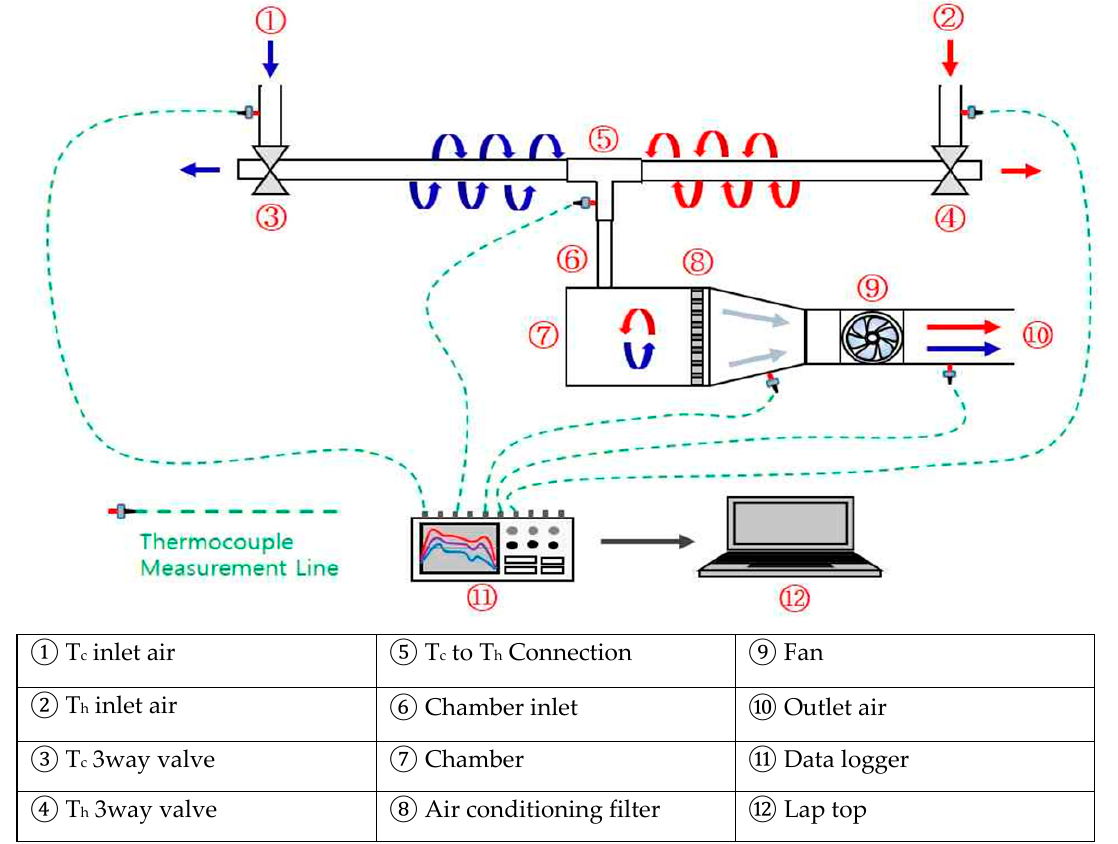
Figure 9. Schematic diagram of the direct air conditioning filter. Energies 2020 , 13 , x FOR PEER REVIEW